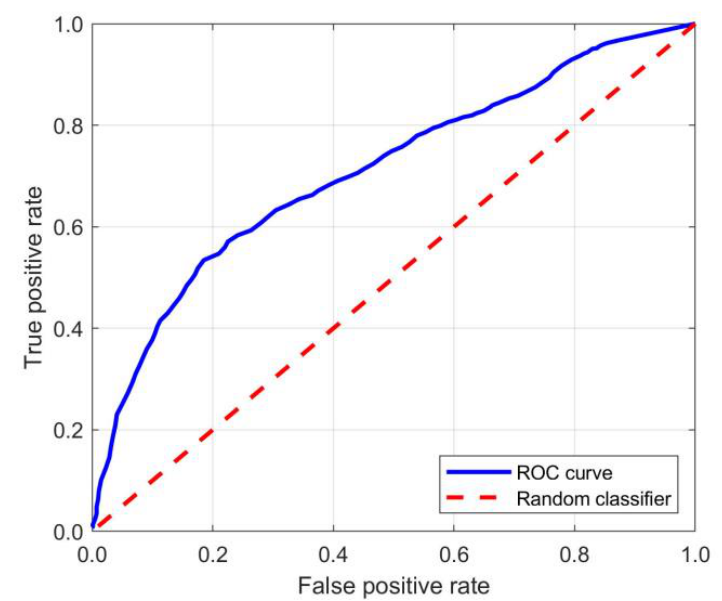
Figure 13. The ROC curve for the kinematics susceptibility analysis. Land 2023 , 12 , x FOR PEER REVIEW